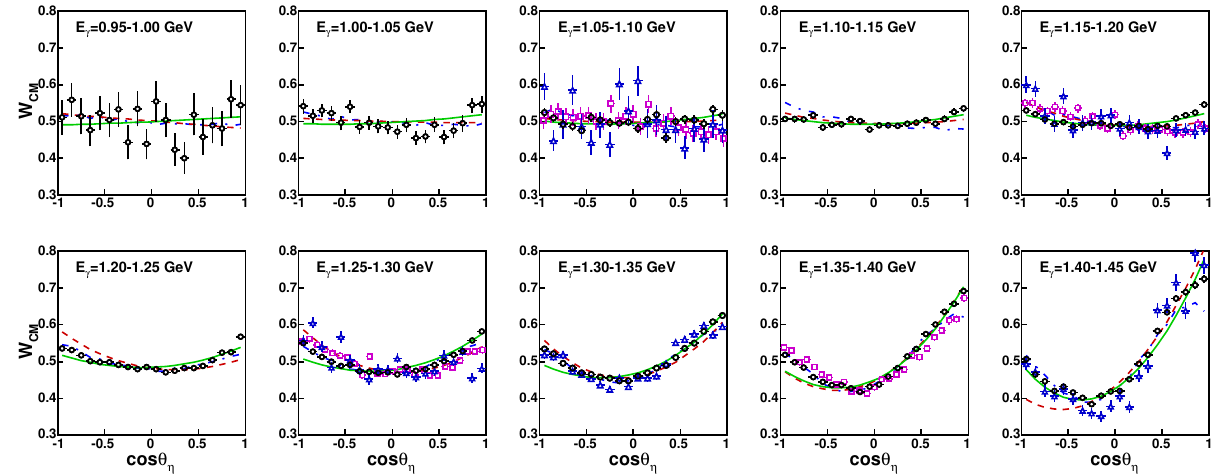
Figure 5. Angular distributions W CM ( θ η ) (normalized to unity) for the reaction γ p → p π 0 η : New A2 data (open circles), data from CBELSA / TAPS [27, 29] (blue stars, combination of results from both papers), and previous A2 data [24, 35] (magenta open squares) at energies close to the ones from the new data set. Theoretical curves: Predictions of the BnGa PWA [29] (blue dash-dotted curve), previous version of the Mainz model [26] (red dashed curve), and the new version of the Mainz model where the new A2 data were included (solid green curve). Figure taken from Ref. [37].